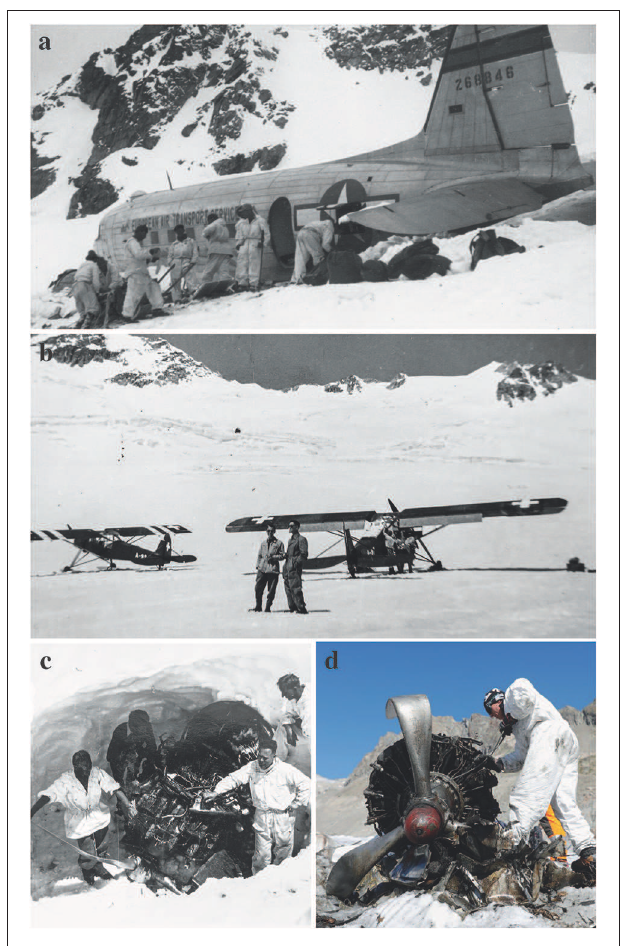
FIGURE 1 | Historical and recent photographs showing (a) the Dakota aircraft during the rescue operation in 1946 (Foto MHMLW, source: www.vtg.admin. ch), (b) the two airplanes used for the recovery of the most valuable pieces in 1947 (source: Swiss Alpine Museum), (c) the removal of one engine while the Dakota was already covered by snow in 1947 (source: Swiss Alpine Museum) (d) the engine released at the surface of the glacier and found in 2018 (Foto VBS, source: